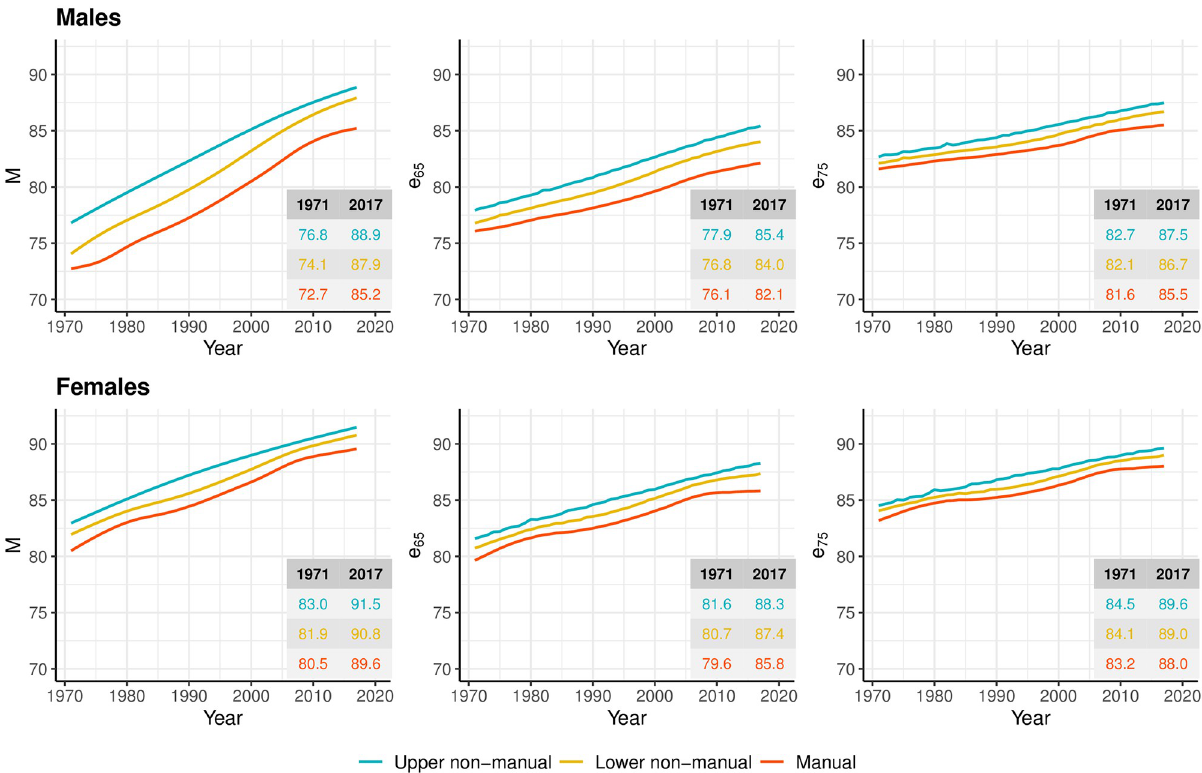
Fig 4. Modal age at death ( M ) and conditional life expectancies at age 65 and 75 (e 65 , e 75 ) based on smoothed age-at-death distributions by occupational class and sex, Finland, 1971–2017. Smoothing was based on ages above 31.